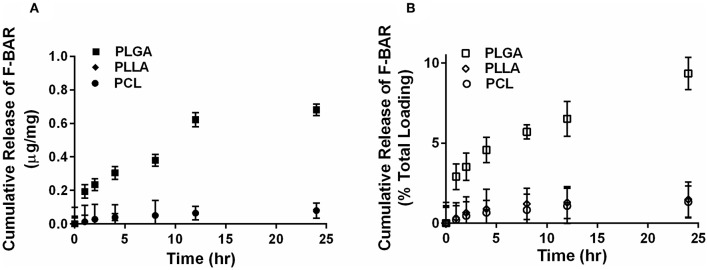
The cumulative release of F-BAR from 1% w/w F-BAR non-blended (100:0) PLGA, PLLA, and PCL fibers. The cumulative release is reported as (A) μg F-BAR per mg of fiber, and (B) percent of total loaded F-BAR. PLGA showed the greatest release of incorporated BAR among the non-blended formulations at 24 h. Error bars represent the mean ± the standard deviation (n = 3) of three independent experiments.